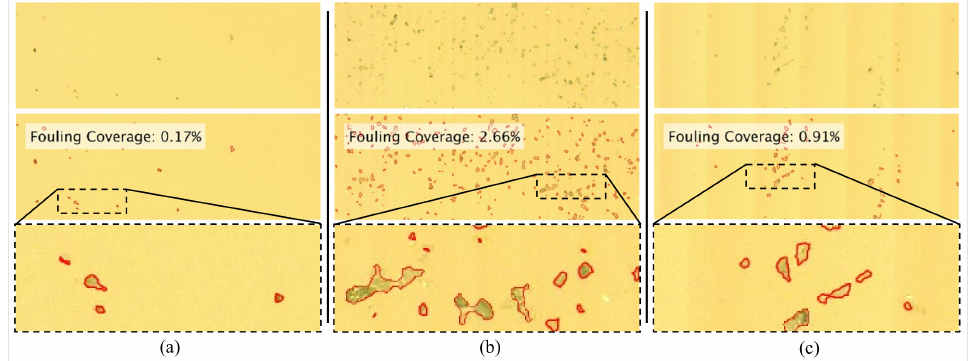
Figure 13. Representative experimental examples of fouling: ( a ) smooth reference, ( b ) 8 µ m, and ( c ) 32 µ m